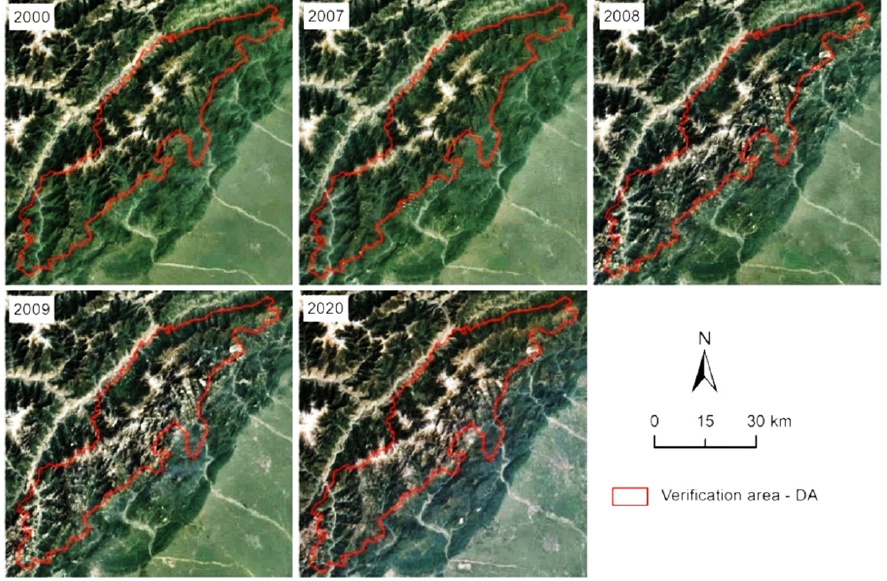
Figure 6. Remote sensing images of DA in 2000, 2007, 2008, 2009, and 2020.